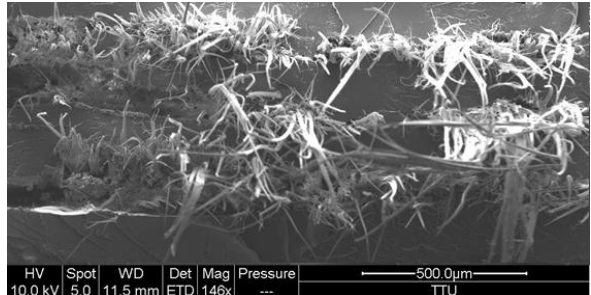
Figure 18. SEM image of CFRAM nylon-Kevlar.